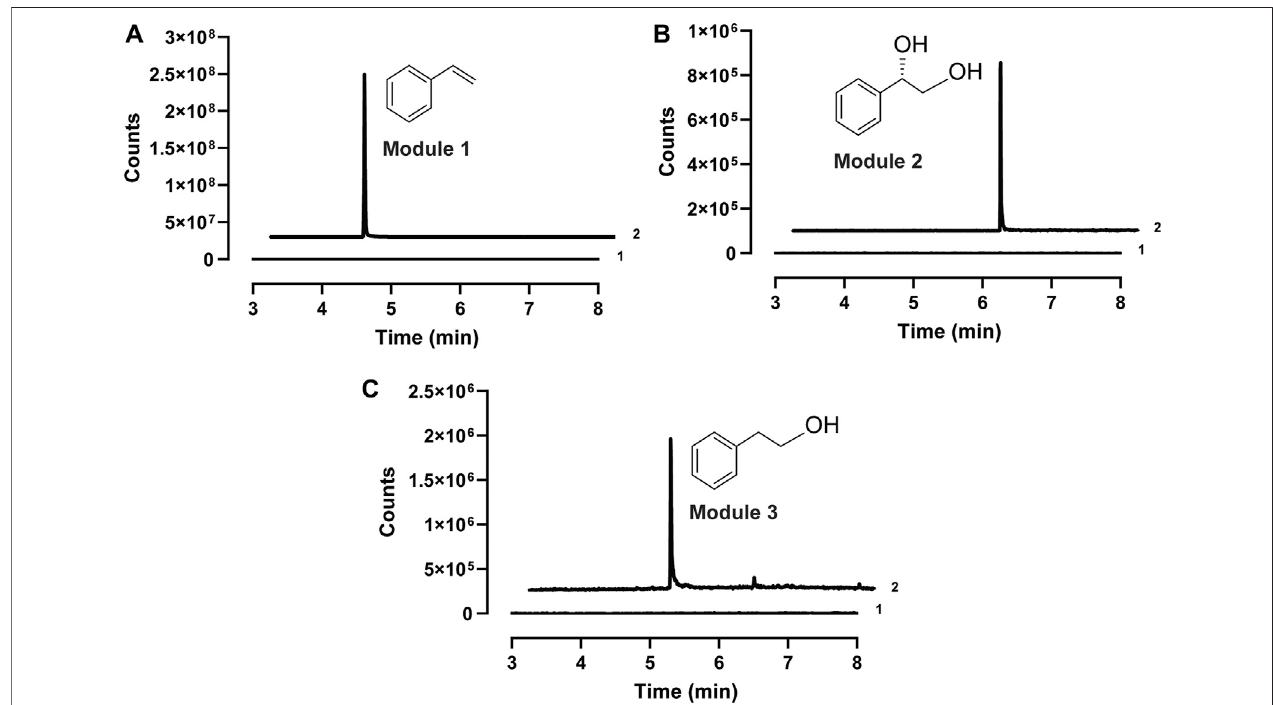
FIGURE3| Extractedionchromatograms(EIC)oftheGC-MSdetectionof (A) styrene(m/z140)inmodule1, (B) ( S )-PED(m/z 138)inmodule2,and (C) 2-PE(m/z 122) in module 3. In each panel, 1, sample at the reaction time of zero; 2, sample from the reaction fi nished.